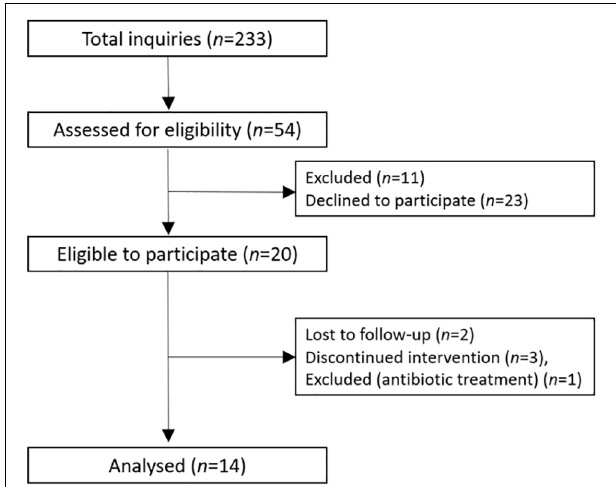
FIGURE 2 | Flow-chart of the